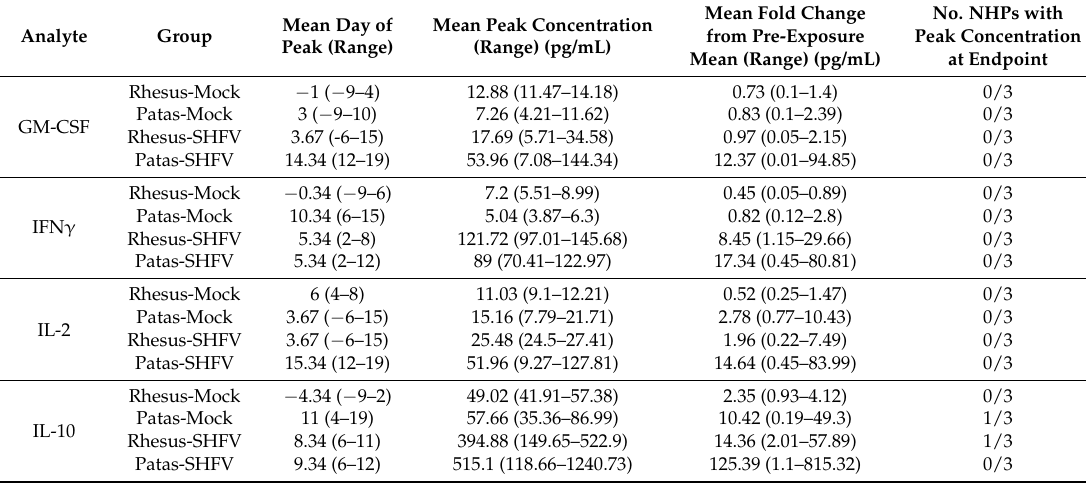
Figure 5. Immunophenotype of the liver and spleen ( A , B ) and plasma cytokine concentrations of SHFV-infected and mock-infected animals. The mean quantitative immunohistochemistry values of the indicated marker in mock- and SHFV-inoculated patas and rhesus monkey livers and spleens ( A , B ). The mean plasma concentrations in pg per mL of indicated analyte for mock (open symbols) and SHFV-inoculated (closed symbols) patas monkeys (orange) and rhesus monkeys (blue) ( C – K ). The gray lines represent the lower and upper limits of quantitation (LLOQ and ULOQ, respectively). The error bars represent standard deviation. * symbols represent p < 0.05 and are colored according to species.